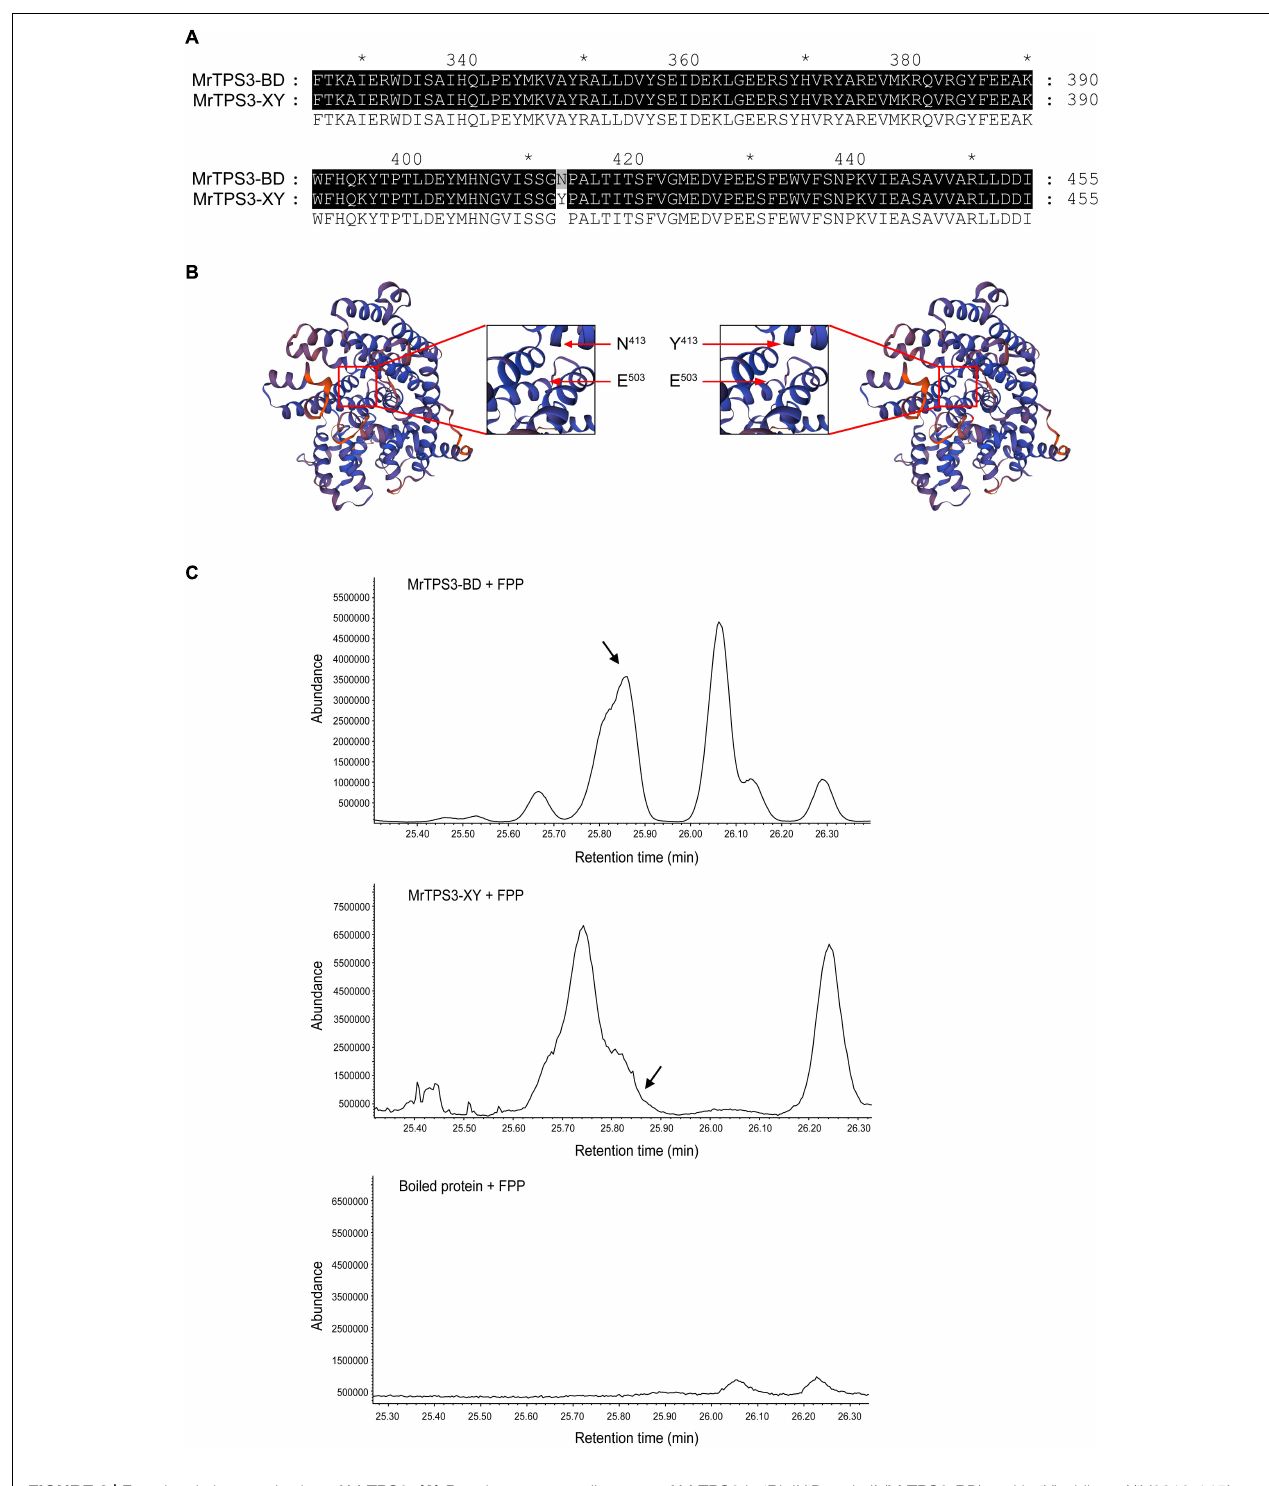
Frontiers in Plant Science |